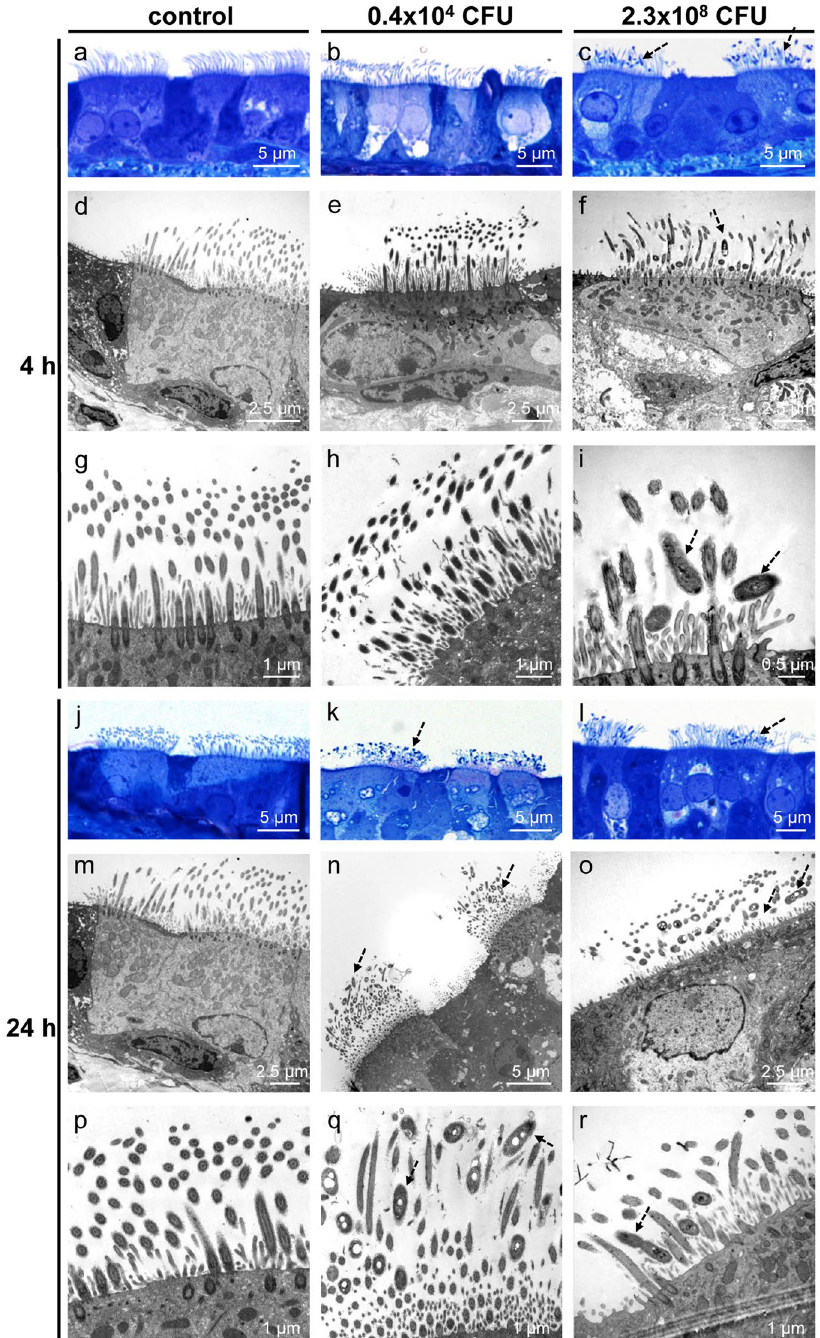
Figure 6. B. pseudohinzii (strain 3227) attaches to and intermingles with cilia in an in vitro -infection model. Tracheal explants were cultured for 24 h, with following addition of bacteria for 4 h ( a–i ) or 24 h ( j–r ). ( a–c ) Semithin sections of tracheal explants cultured for 24 + 4 h, light microscopy. ( a ) Without adding of bacteria, cilia are normally orientated and no bacteria are visible. ( b ) B. pseudohinzii (0.4 × 10 4 CFU) was added for 4 h. No bacteria are seen. ( c ) B. pseudohinzii (2.3 × 10 8 CFU) was added for 4 h. Bacteria attach to cilia ( dotted arrows ). ( d–i ) Transmission electron microscopy. ( d , g ) Control experiment. Tracheas were cultured for 24 + 4 h without bacteria. Cilia appear normal in length and orientation. No signs of cell damage. ( e , h ) No obvious difference to controls 4 h after incubation with 0.4 × 10 4 CFU B. pseudohinzii . ( f , i ) B. pseudohinzii (2.3 × 10 8 CFU) was added for 4 h. Bacteria are located between the cilia ( dotted arrow ), ( j , m , p ) Control. Explants cultivated for 24 h without bacteria demonstrate unaltered ciliated cells in light ( j ) and transmission electron microscopy ( m , p ). ( k , n , q ). B. pseudohinzii (0.4 × 10 4 CFU) was added for 24 h. Bacteria ( dotted arrows ) intermingle with kinocilia. They are not seen at non-ciliated cells. ( l , o , r ) B. pseudohinzii (2.3 × 10 8 CFU) was added for 24 h. The number of bacteria ( dotted arrows ) is increased, cells with shortened of cilia can be observed in transmission electron microscopy ( o , r